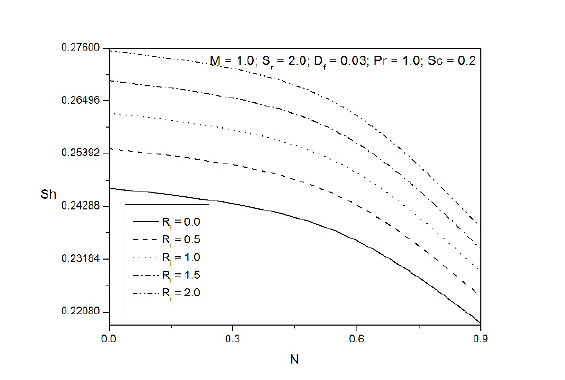
Figure 4. Concentration profile for various values of Magnetic pa- rameter M